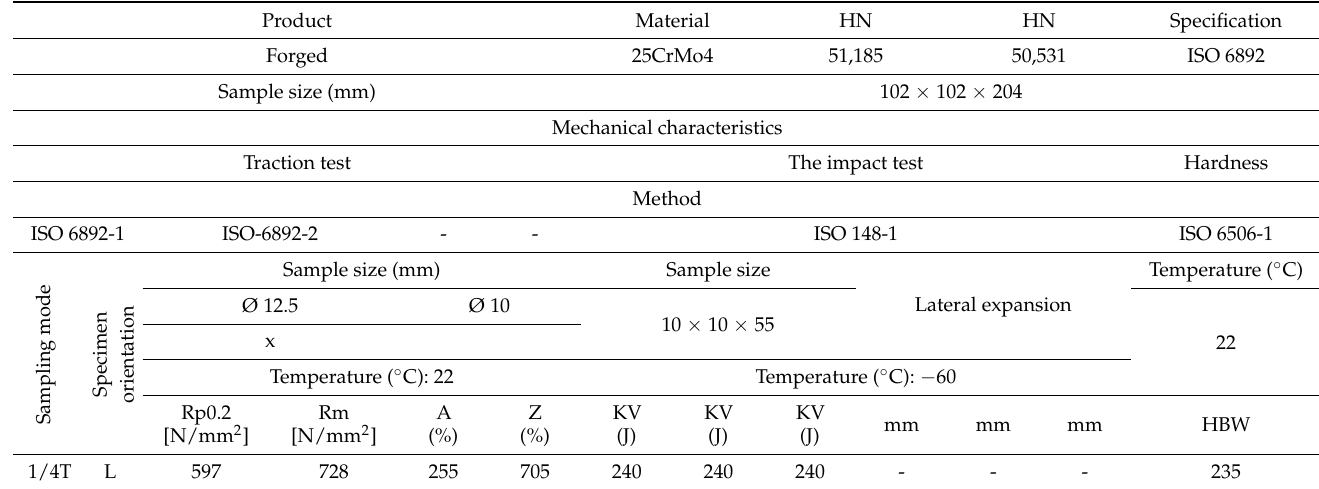
Table 7. The results of the mechanical tests for 25CrMo4